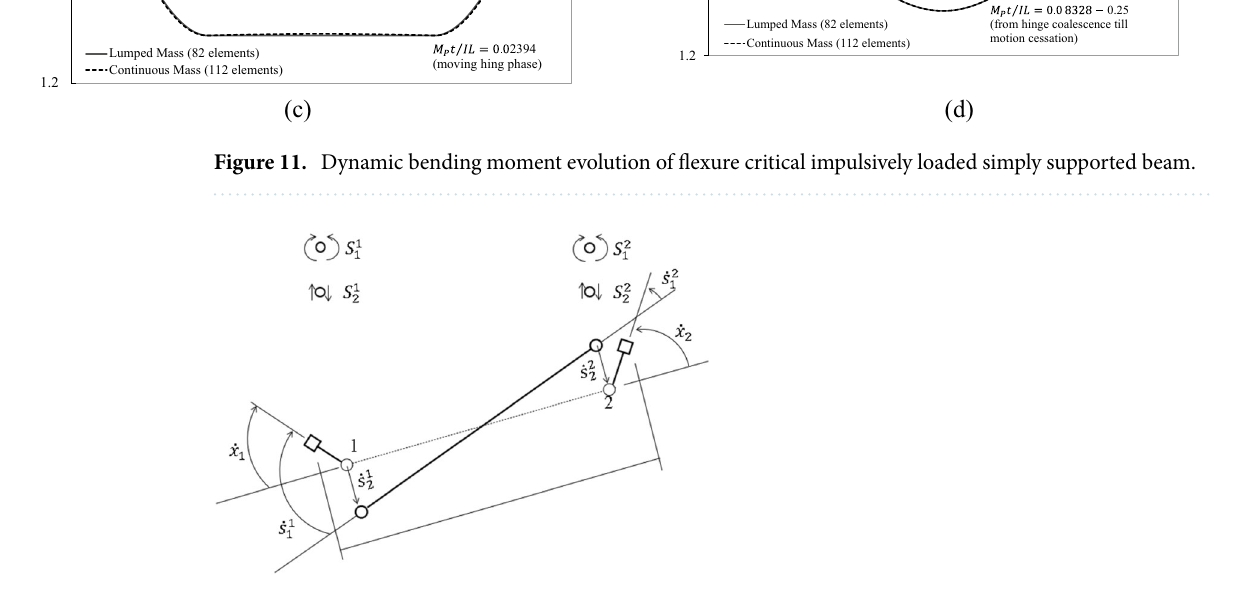
Figure 12. Stress and strain resultants related by the interaction of transverse shear force and bending